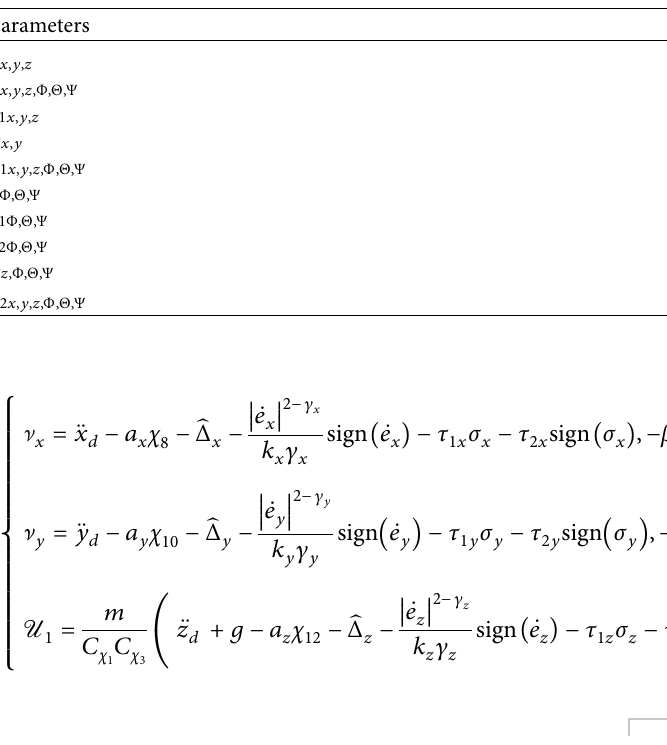
Table 2: Controller’s